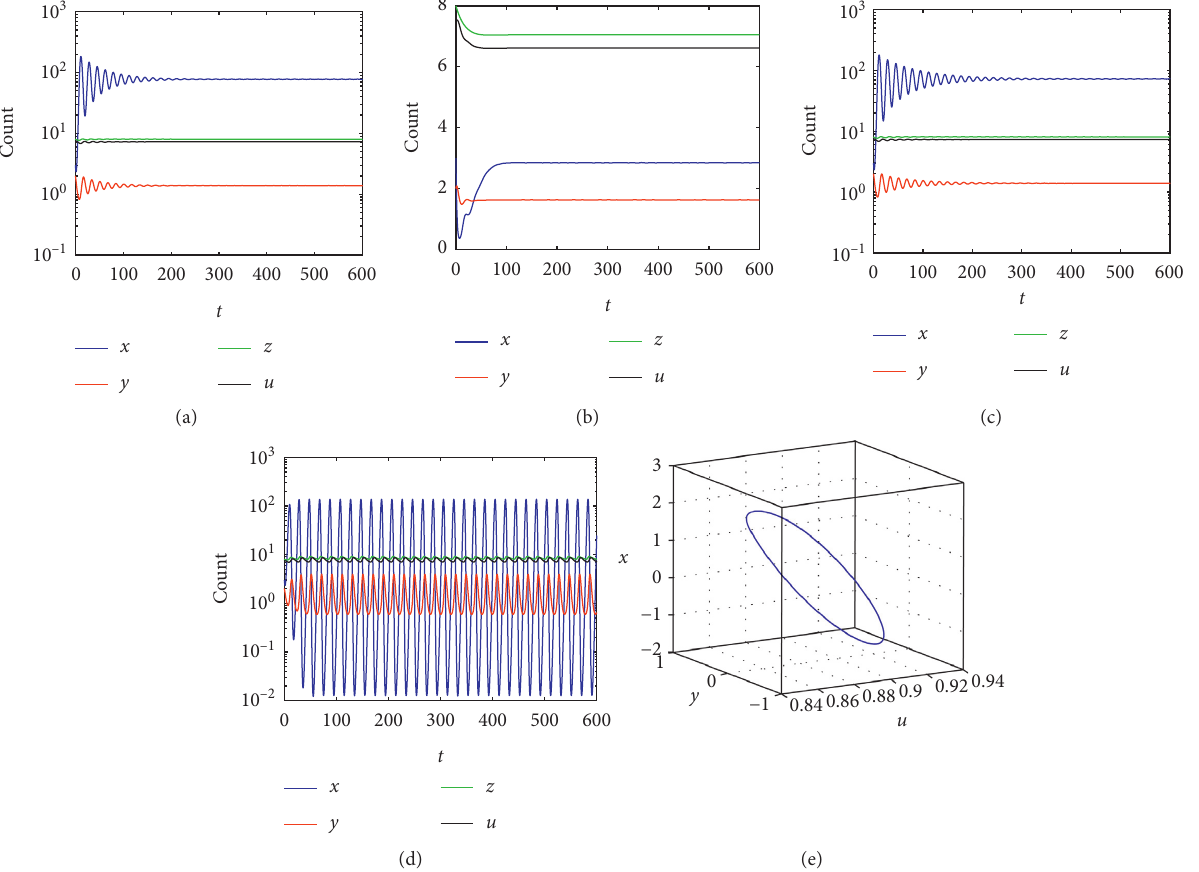
Figure 3: The other parameter values are given in (22). (a) P ∗ ( 2 . 844 , 1 . 626 , 7 . 055 , 6 . 62 ) is LAS, θ � 0 . 455and ω P ∗ 2 ( 26 . 365 , 1 . 549 , 8 . 548 , 7 . 768 ) is unstable, θ � 0 . 48 and ω (d) P ∗ 4 � 0 . θ � 0 . 48 and ω 2